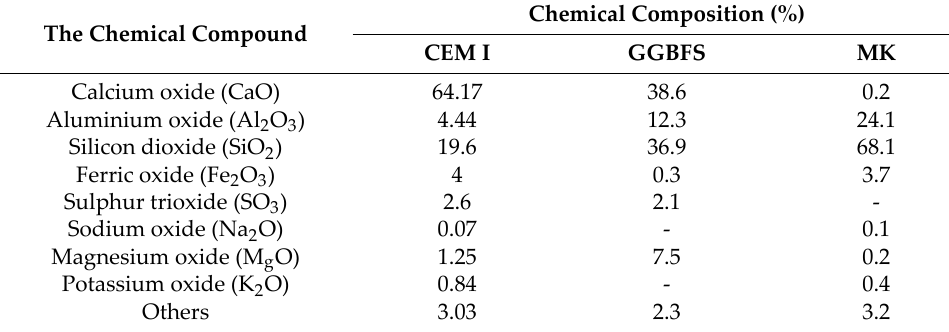
Table 1. Chemical composition of cement and pozzolans used in this study.